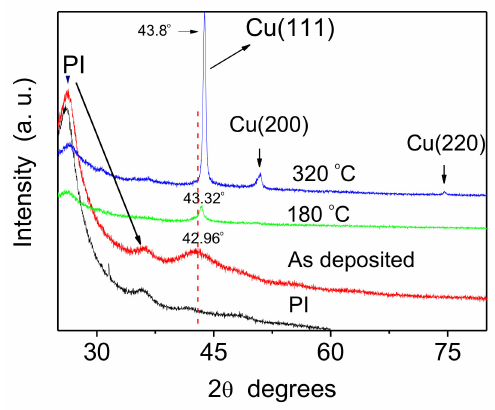
Figure 3. XRD patterns of the polyimide (PI) substrate, and the deposited and annealed Cu-17.1%Zr alloy films.